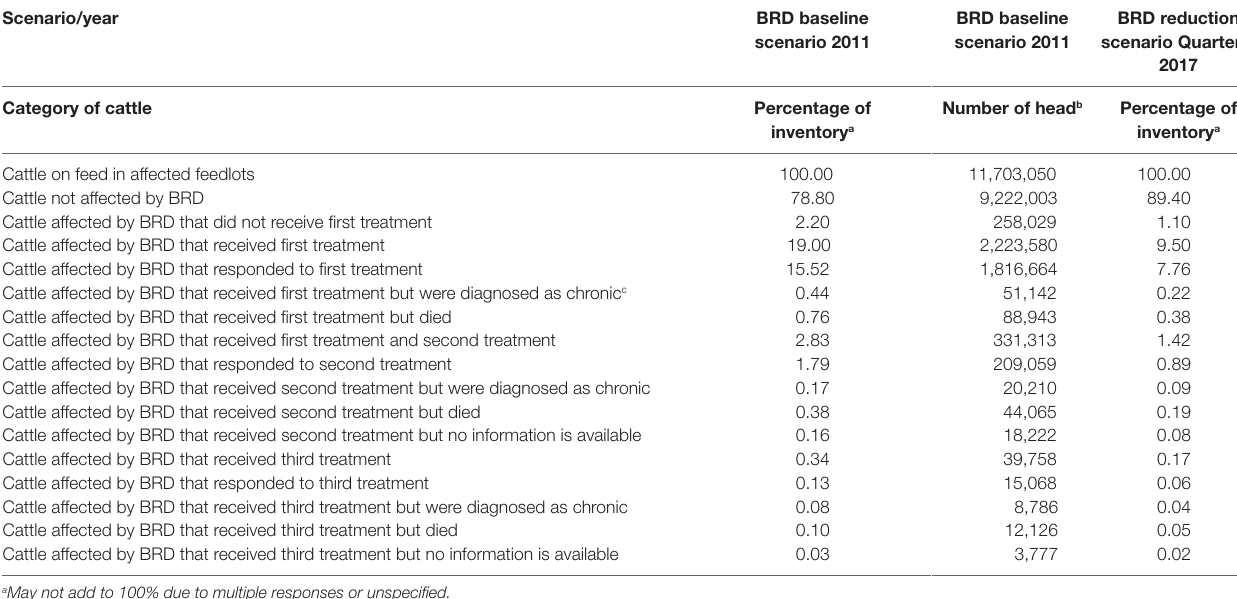
TaBle 2 | Number of cattle on feed and percentage of cattle on feed inventory affected by BRD, by category of cattle and scenario.